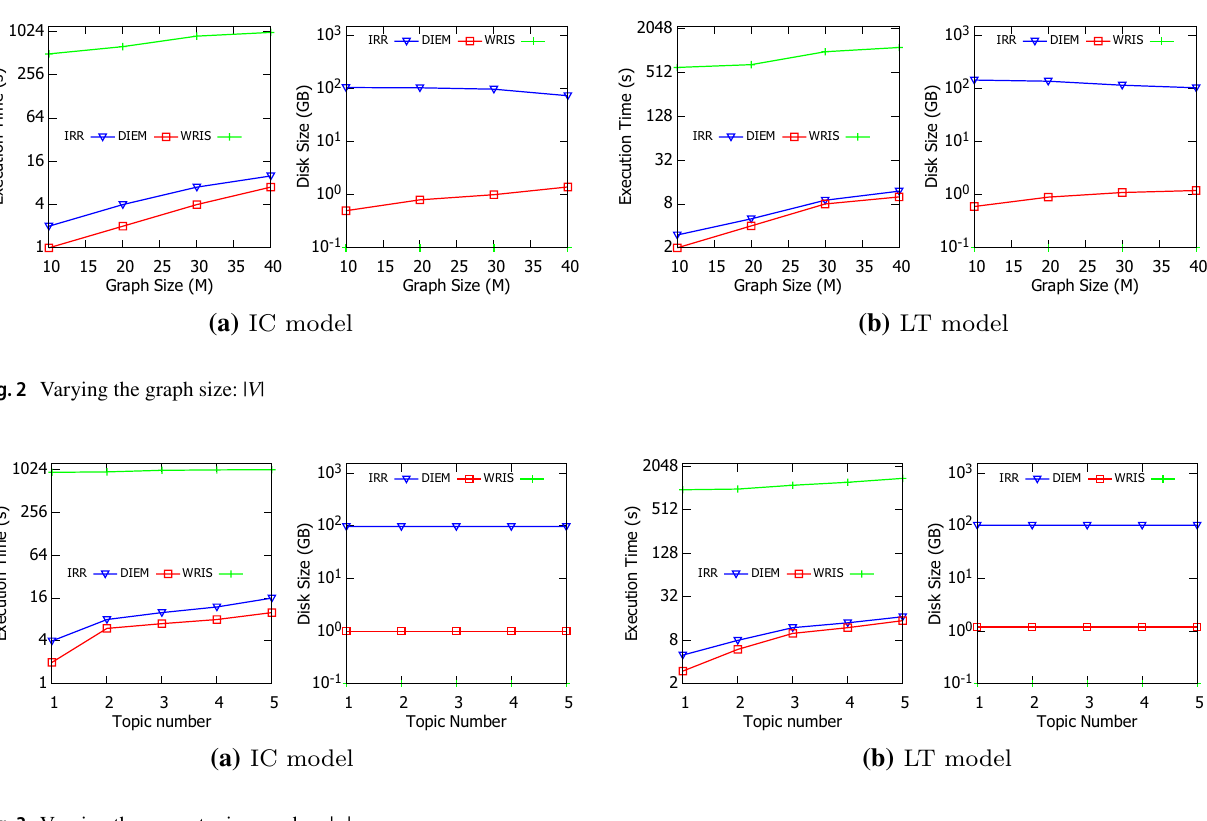
Fig. 3 Varying the query topics number: